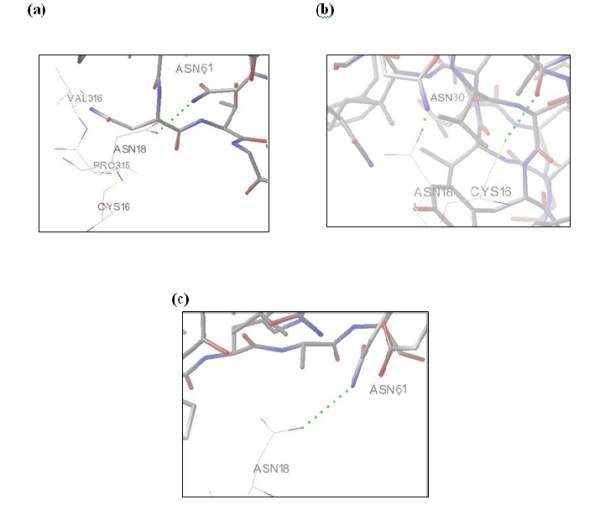
Docking of GNA lectin with HCV glycoprotein. (a) Interaction of Asn18 of HCV with Asn61 of 1JPC GNA lectin. (b) Interaction of Asn18 of HCV with Asn30 of 1JPC GNA lectin. (c) Interaction of Asn18 of HCV with Asn61 of 1NIV GNA lectin